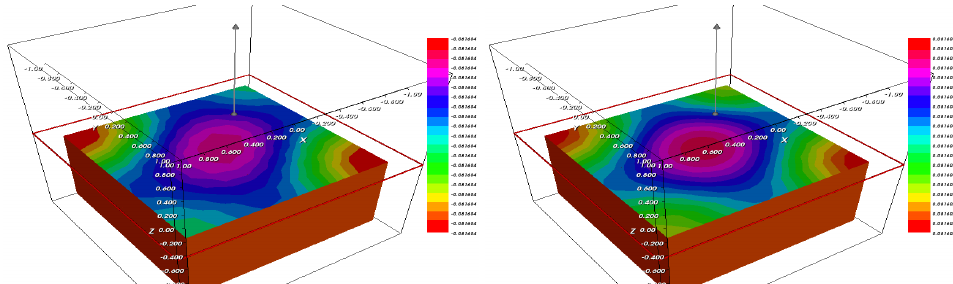
Figure 3. The fraction ϕ ( left ) and ψ ( right ) after T = 15.